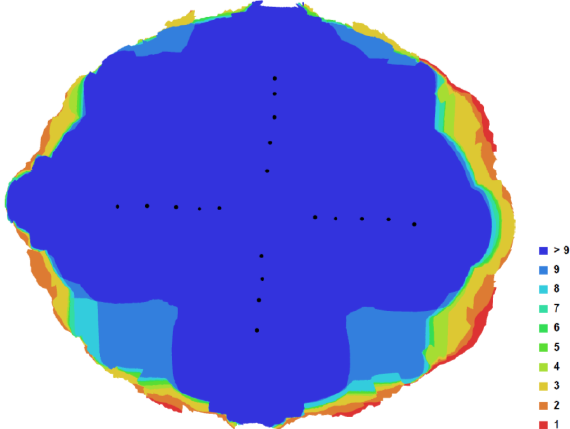
Figure 4 Camera locations and multiple image